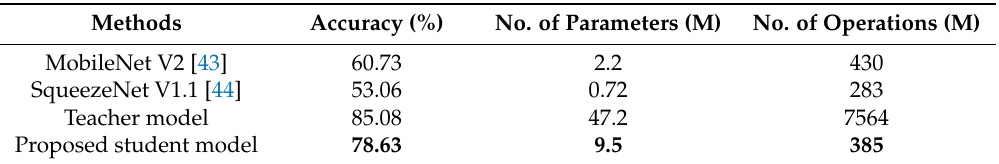
Table 2. Comparison between the numbers of parameters and operations for the proposed method and two state-of-the-art compression models using the TUD dataset.